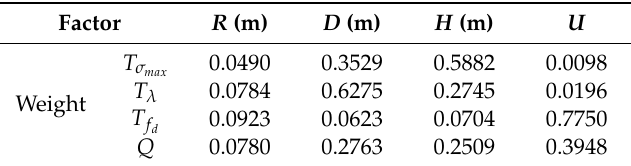
Table 9. Influence weight of factors.